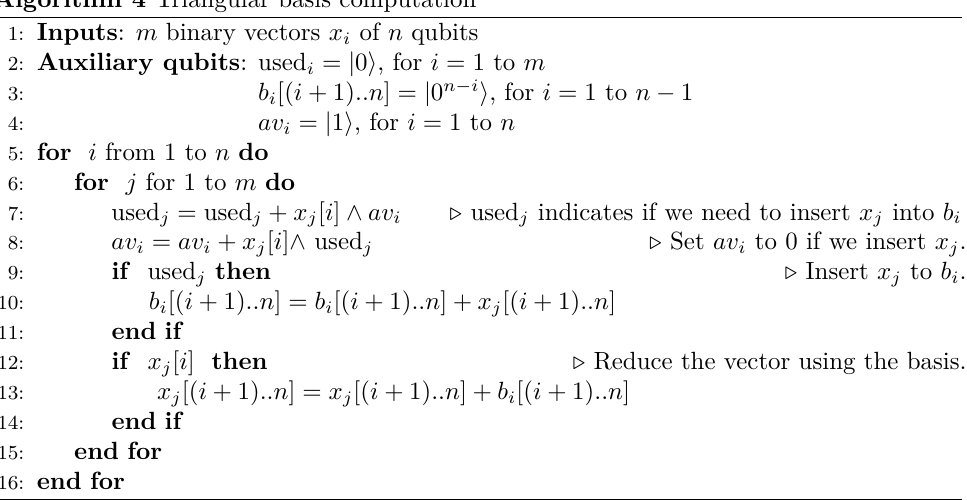
Algorithm 4 Triangular basis